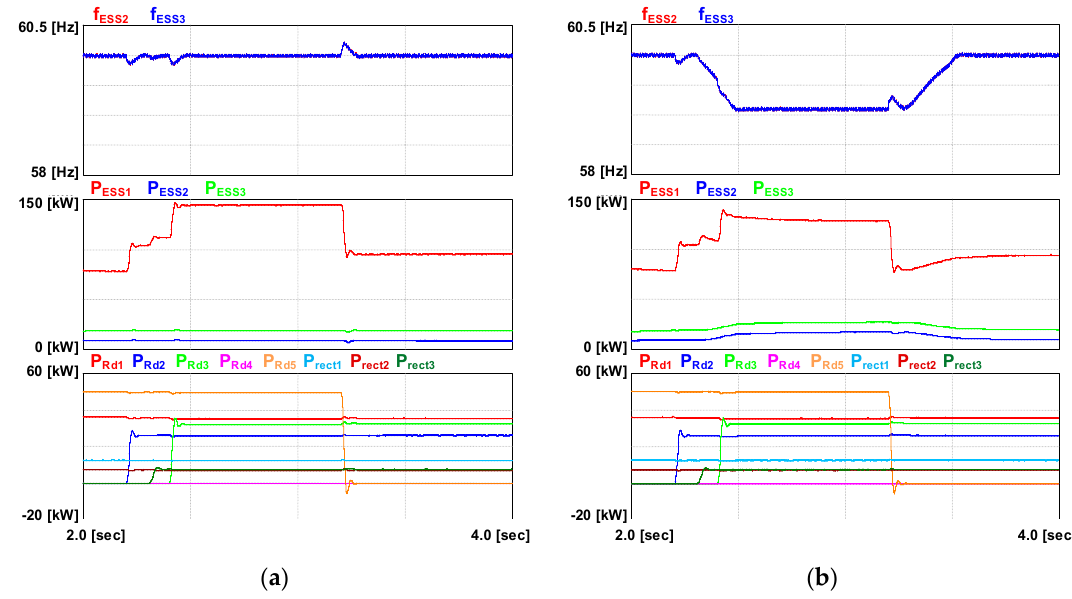
Figure 9. Simulation results (frequency shift)—( a ) constant frequency; ( b ) variable frequency.